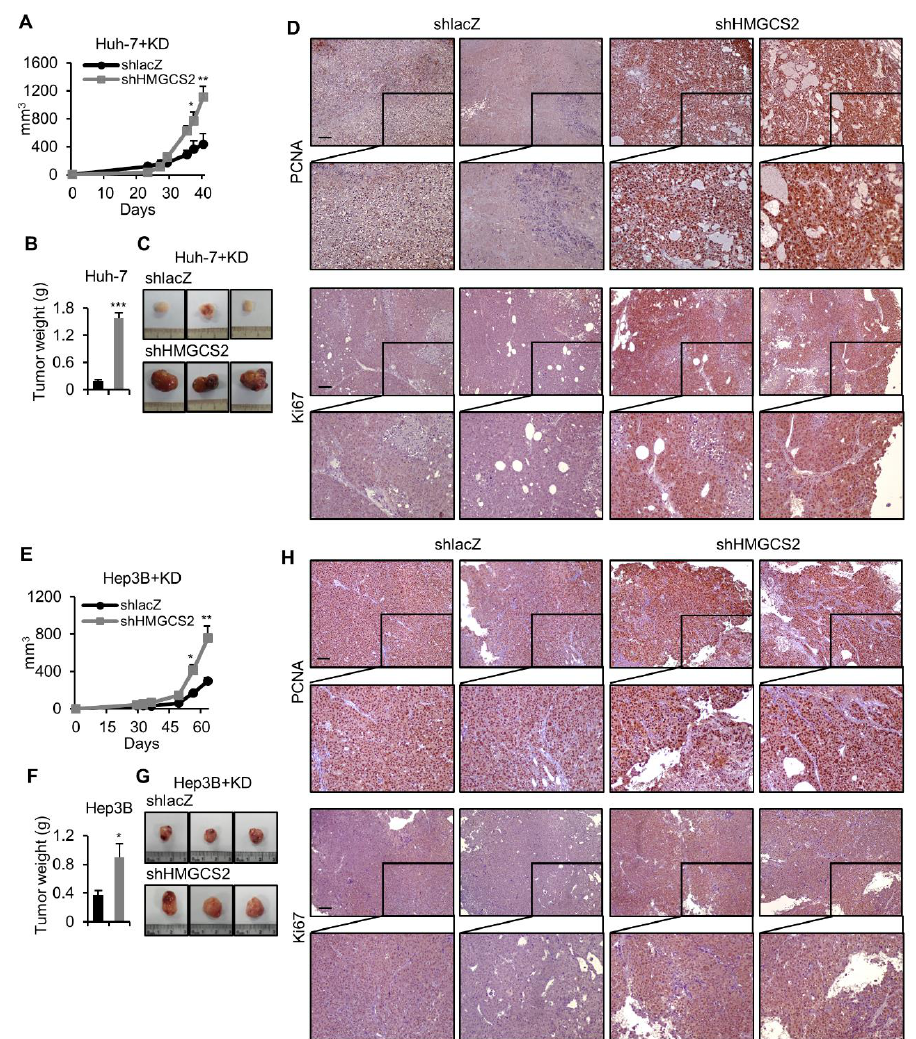
Figure 4. The knockdown of HMGCS2 enhanced tumor growth under KD feeding. ( A , E ) The tumor growth rate and ( B , F ) the tumor weight from mice fed either an ND or KD. Huh-7 + KD: n = 7 / group. Hep3B + KD: n = 5 / group. ( C , G ) Representative images of tumors from each group. ( D , H ) Representative PCNA and Ki67 IHC staining of tumors from each treatment group. The Mann–Whitney U test was used to compare two independent groups. * p < 0.05; ** p < 0.01; *** p < 0.001 vs. the black